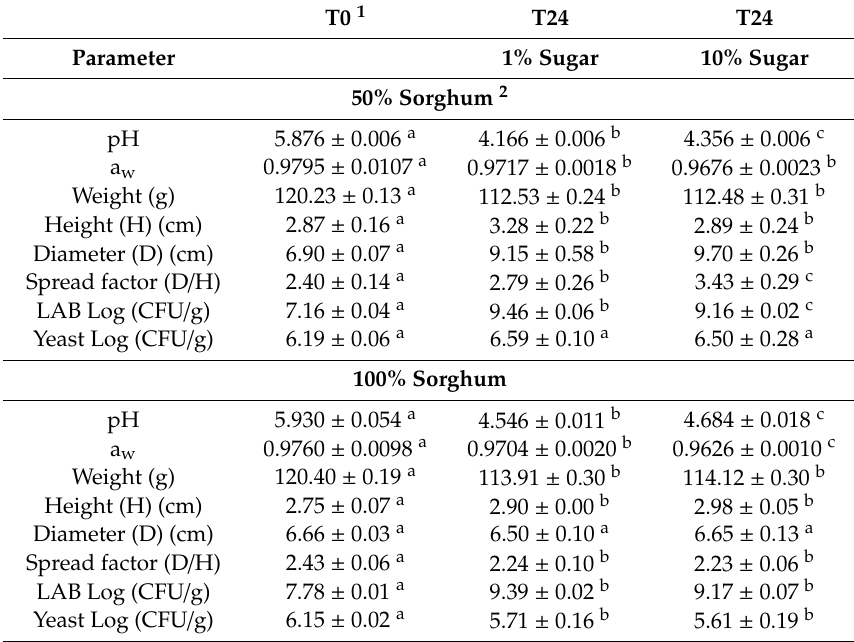
Table 3. Results of the dough made with yeast and LAB, sorghum flour, and sucrose